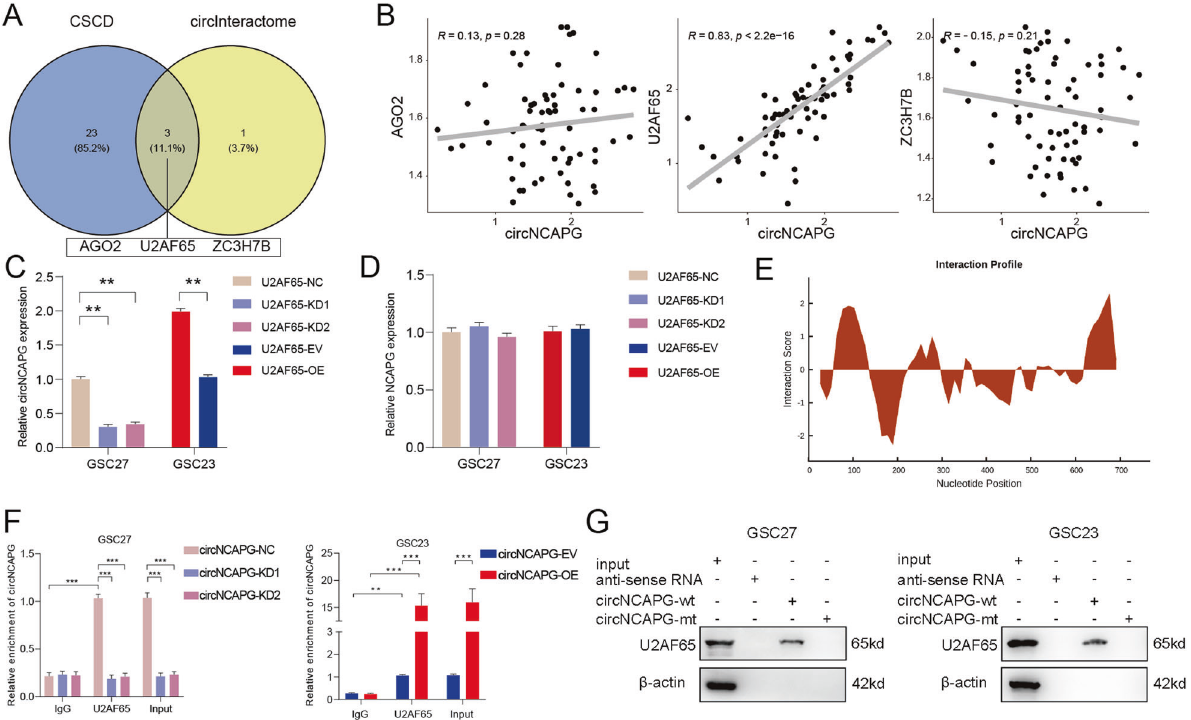
Fig. 3 U2AF65 can bind to circNCAPG in GSCs. A The predictions of RNA-binding proteins for circNCAPG are based on CSCD and the circInteractome database. B The gene expression correlation analysis between AGO2, U2AF65, ZC3H7B and circNCAPG. C , D The qPCR assay revealed the changes of circNCAPG and NCAPG mRNA levels in different GSC groups after U2AF65 knockdown or overexpression treatment. E The predicted binding site between circNCAPG and U2AF65 according to the catRAPID database. F The RIP assays revealed enrichment levels of circNCAPG in different GSC groups. G The western blotting revealed that the U2AF65 protein immunoprecipitated with circNCAPG in the RNA pull-down assays. All results are presented as the mean ± SD (three independent experiments). * p < 0.05; ** p < 0.01; *** p <